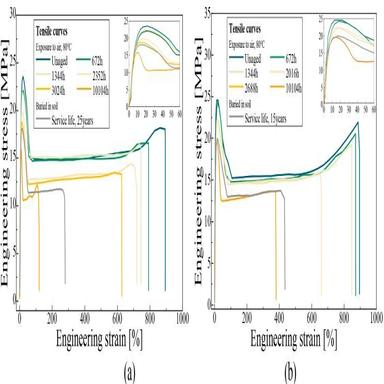
Effect of exposure time on typical stress-strain curve of PE80 (a) and PE100 (b).